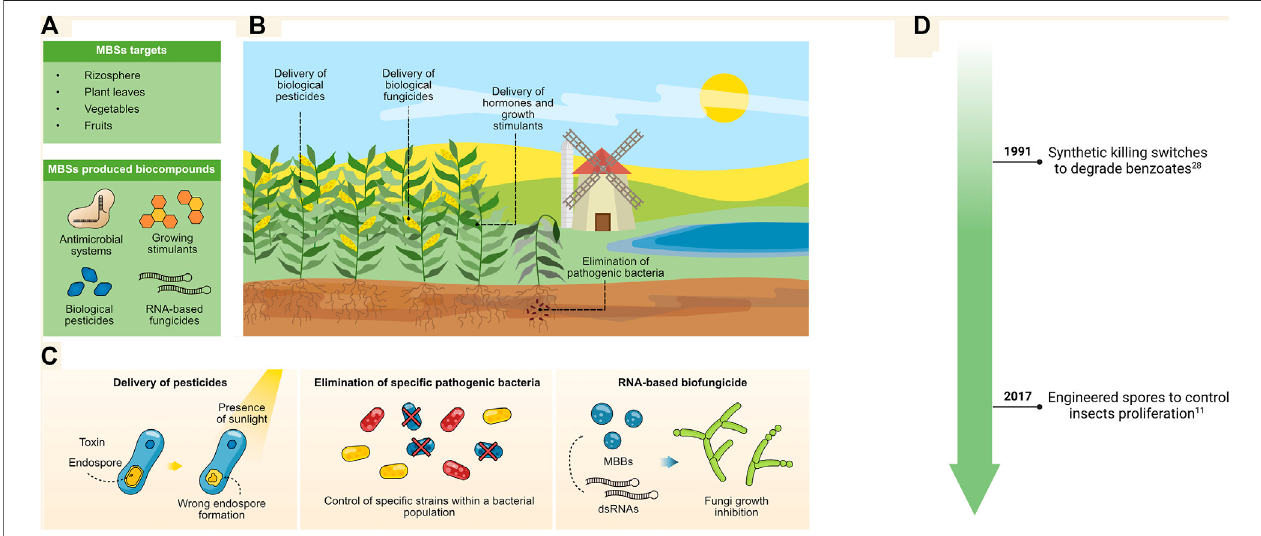
FIGURE 5 |(A,B) MBSs can be used for the delivery of antimicrobial systems and biologicals in crop fi elds. (C) MBSs that produce toxinscan be sensitized toUV, allowing them to deliver biological pesticides and be removed upon exposure to sunlight (left panel), they can also be engineered to deliver antimicrobial systems for the removal of pathogenic strains trough CRISPR/Cas-based genetic devices (middle panel) or by delivery of RNA-based knockdown devices. (D) Timeline for major environmental